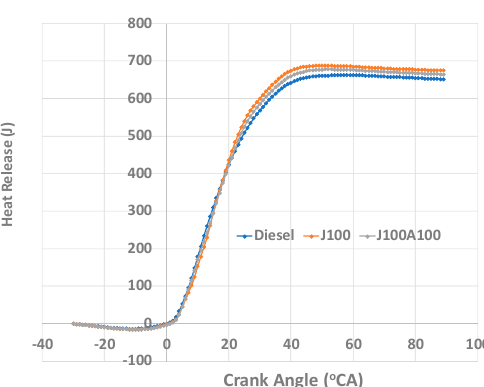
Figure 16. Total heat release at 100% load.